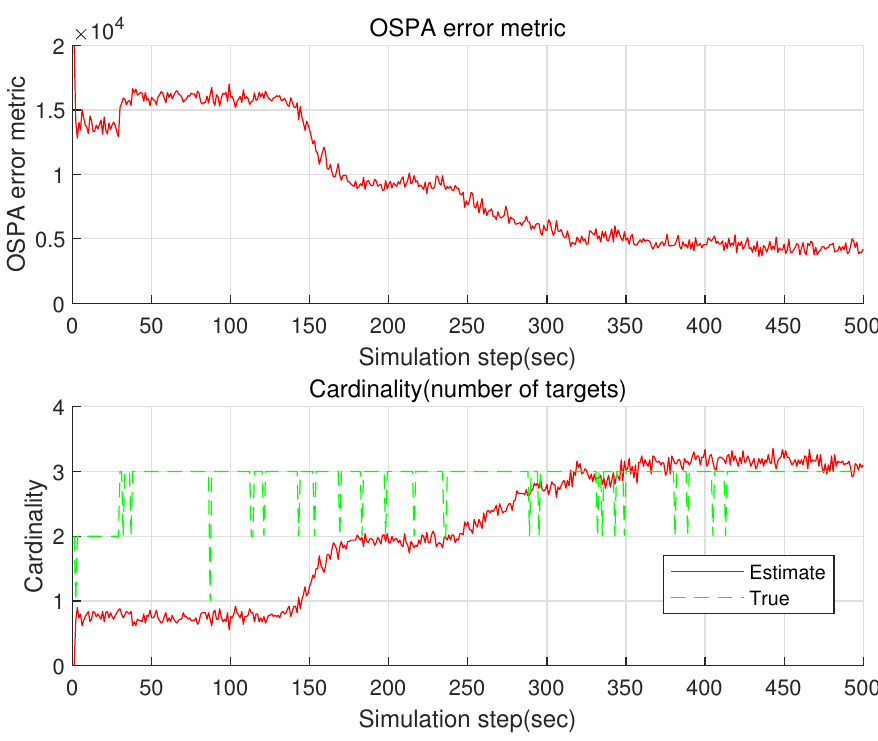
Figure 7. The OSPA and the cardinality of the proposed GM-PHD in the case where B = 20 is